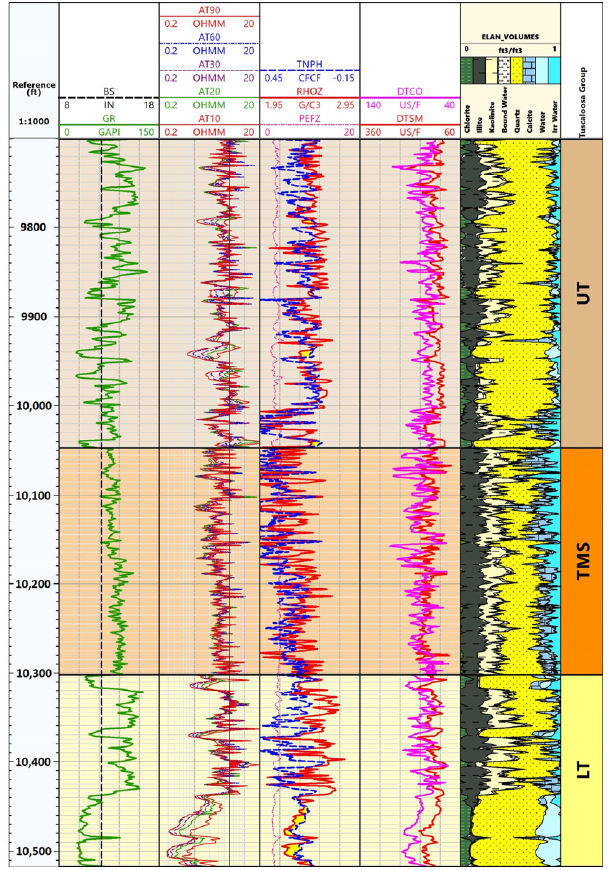
Figure 3. Type log of Well CFU 31F-2 in Cranfield field, MS.